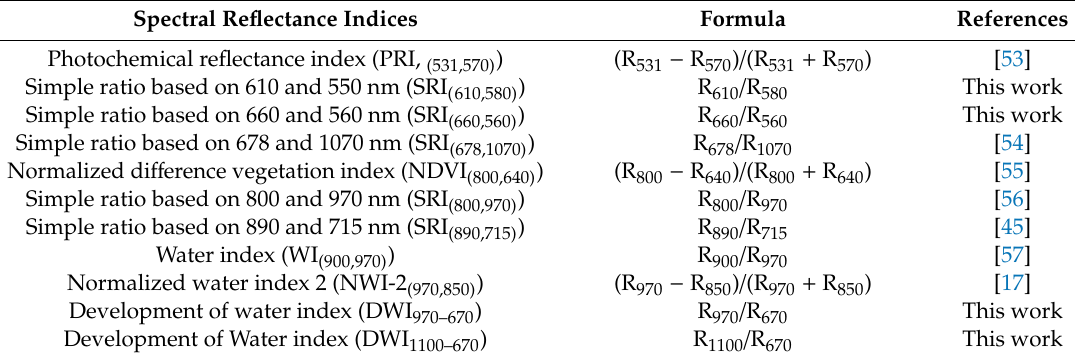
Table 2. Full name, formula, and references of spectral reflectance indices (SRIs) tested in this study. Spectral Reflectance Indices